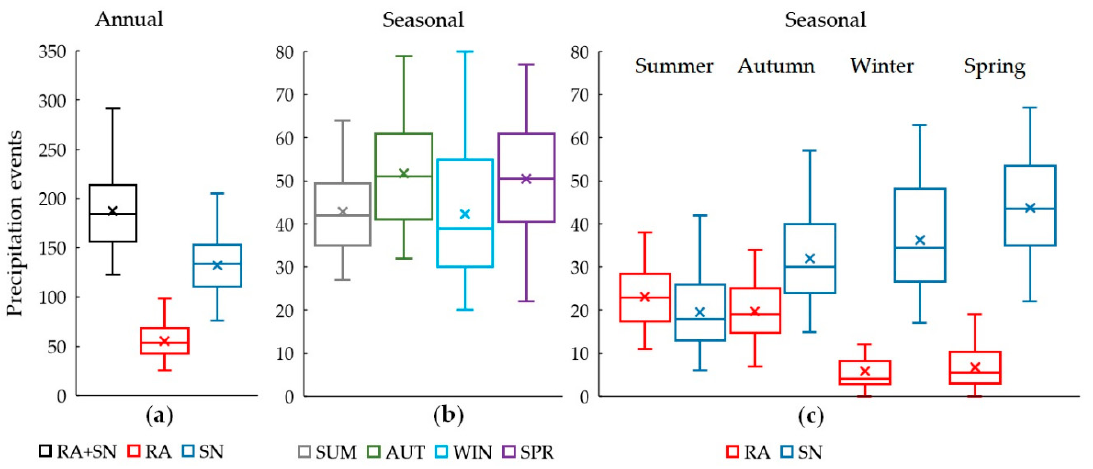
Figure 6. Same as Figure 5, but for the ( a ) annual precipitation events, ( b ) total (RA + SN) seasonal precipitation events and ( c ) seasonal rain and snow events for the 1970–2019 period at Frei station.